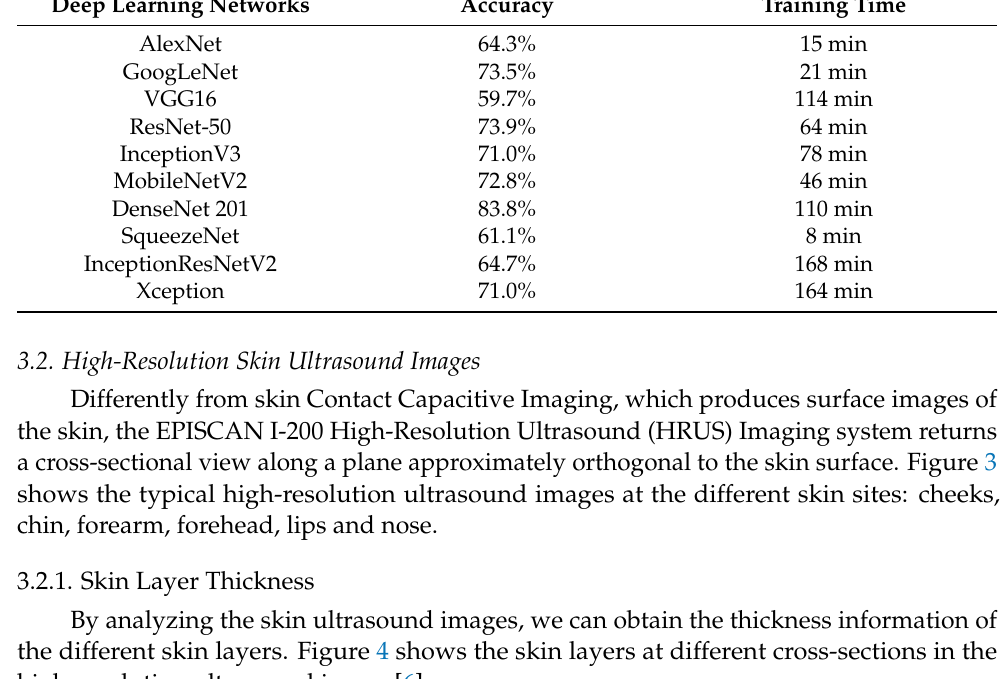
Table 2. The image classification results of different Deep Learning Neural Networks. Deep Learning